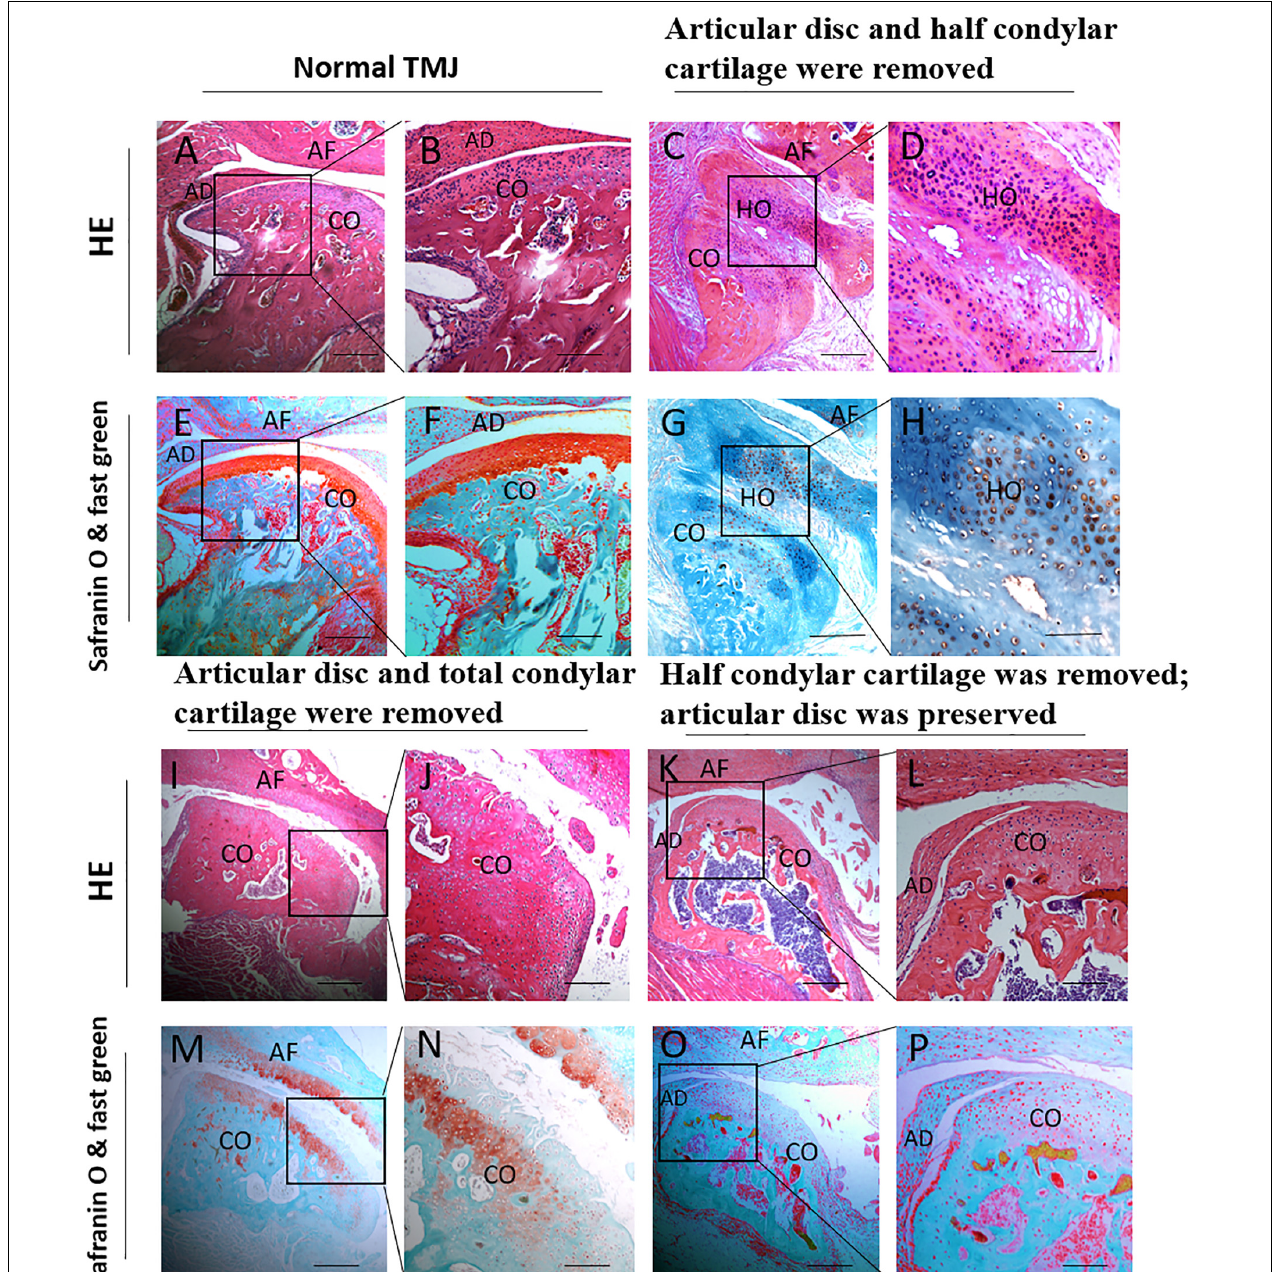
FIGURE 7 | Histological examination of different animal models during the development of TMJ-THO 3 months after surgery. (A,B,E,F) The TMJ structure in normal control mice. (C,D,G,H) There was obvious heterotopic ossification around the injured TMJ, and the structure of the condyle showed an abnormal shape in the first animal model (the articular disc and half condylar cartilage were removed). (I,J,M,N) No obvious heterotopic ossification around the injured condyle in the second animal model (the articular disc and total condylar cartilage were removed). (K,L,O,P) No obvious heterotopic ossification around the injured condyle was observed in the third animal model (half of the condylar cartilage was removed, but the articular disc was preserved). Panels (B,D,F,H,J,L,N,P) are local magnifications of the boxed areas in panels (A,C,E,G,I,K,M,O) , respectively. AD, articular disc; AF: articular fossa; CO, condyle; HO, heterotopic ossification. Scale bar: (A,C,E,G,I,K,M,O) , 200 µ m; (B,D,F,H,J,L,N,P) , 50 µ